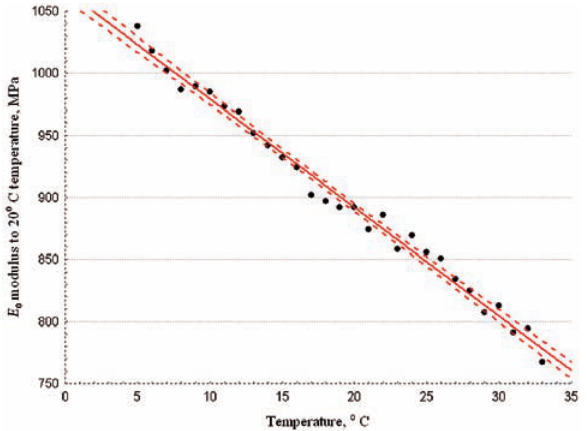
Fig. 4. Correlation of the temperature of structural pavement layers at a 10 cm depth and the E during research